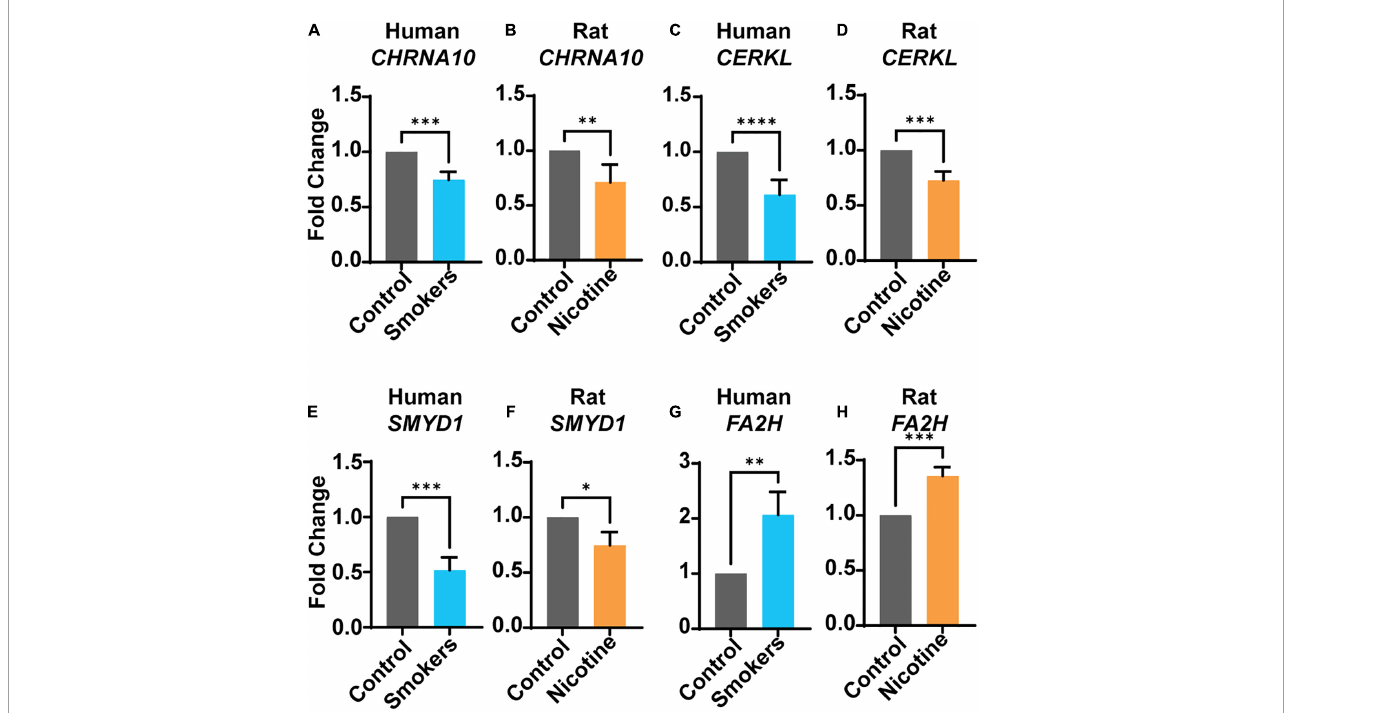
FIGURE1 Gene expression levels in human smokers or rats treated with nicotine. Human (blue bars) smokers or rats (orange bars) treated to nicotine were analyzed. The following genes: CHRNA10 (A,B) , CERKL (C,D) , and SMYD1 (E,F) , were all significantly under-expressed in both species. Gene FA2H (G,H) was significantly higher in both species. Each bar represent the mean ± SEM of 12 humans or rats per group; ∗ p < 0.05; ∗∗ p < 0.01; ∗∗∗ p < 0.001, ∗∗∗∗ p < 0.0001 ( t